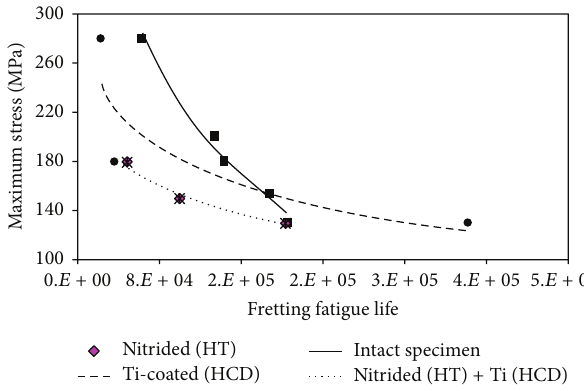
Figure 22: S-N curves for duplex surface treatment, (Ni (HT) + Ti (HCD))